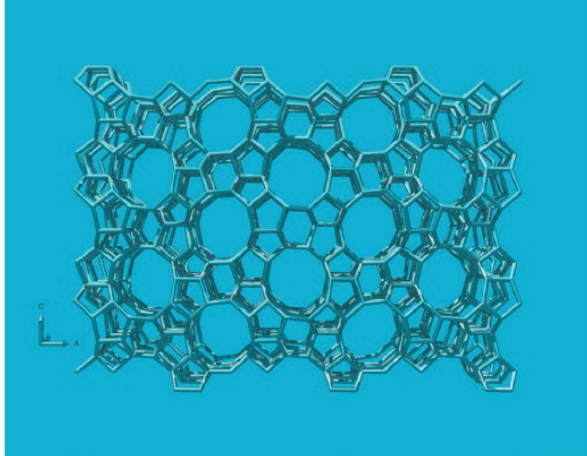
Figure 5. ZSM-5 Zeolite. Adapted from Chemical Society Review 2015 , 44, 7342-7370 - Published by The Royal Society of